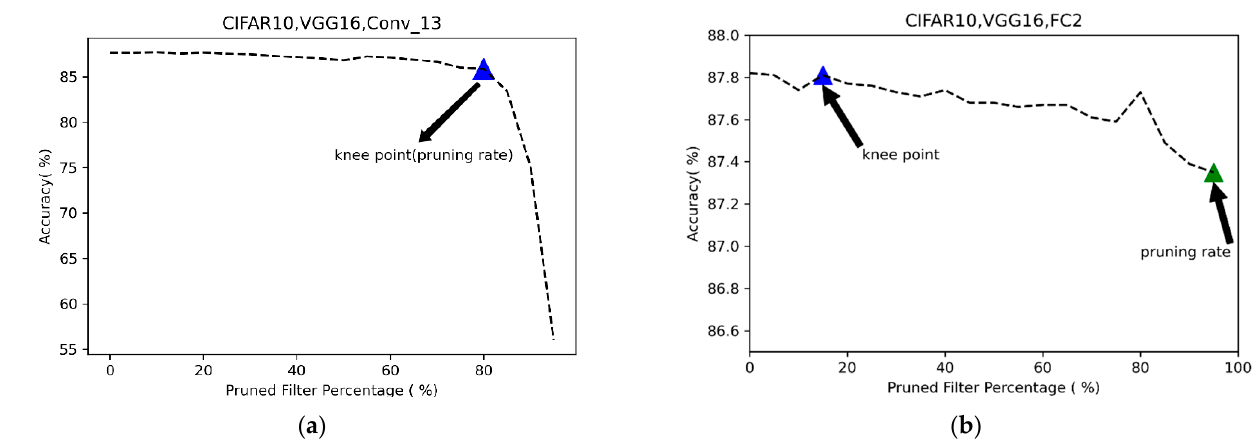
Figure 5. The blue triangles in ( a , b ) are Knee points, which refer to the curve’s change to a sharp decline from the horizontal. ( a ) Shows that the Kneedle algorithm can find the pruning rate well in the general convolution layer. ( b ) Shows that, for some insensitive fully connection layers, the accuracy decreases little, and Kneedle algorithm cannot give an appropriate pruning rate; the green triangle is the maximum pruning rate that meets the threshold.